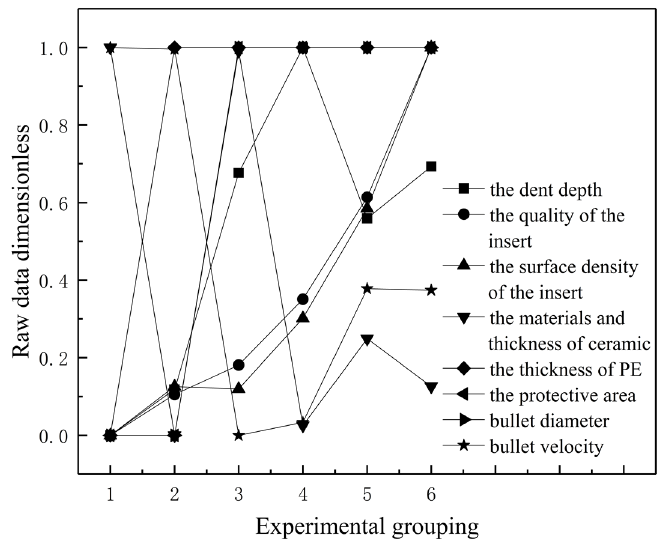
Figure 8. Sequence diagram of factors affecting the depth of the concave backing material (after dimensionless).